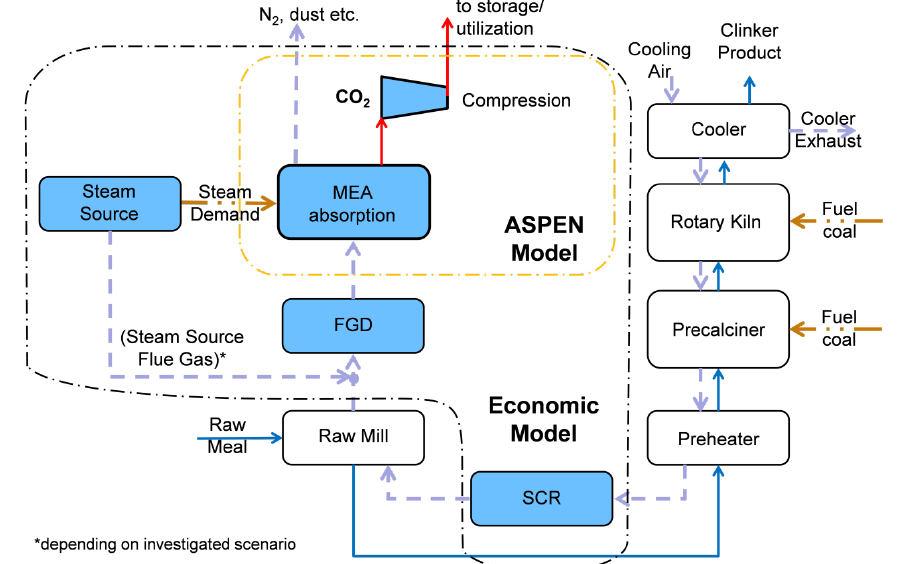
Figure 1. M onoethanolamin (MEA) absorption for cement plant process design, including the Figure 1. Monoethanolamin (MEA) absorption for cement plant process design, including the boundaries for the economic and energy analyses conducted in Aspen. boundaries for the economic and energy analyses conducted in Aspen. Table 2. Energy analysis: Performance indicators for carbon capture, utilization, and storage (CCUS).